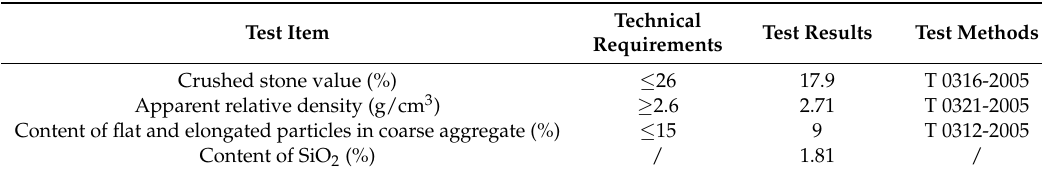
Table 3. Properties of aggregate.